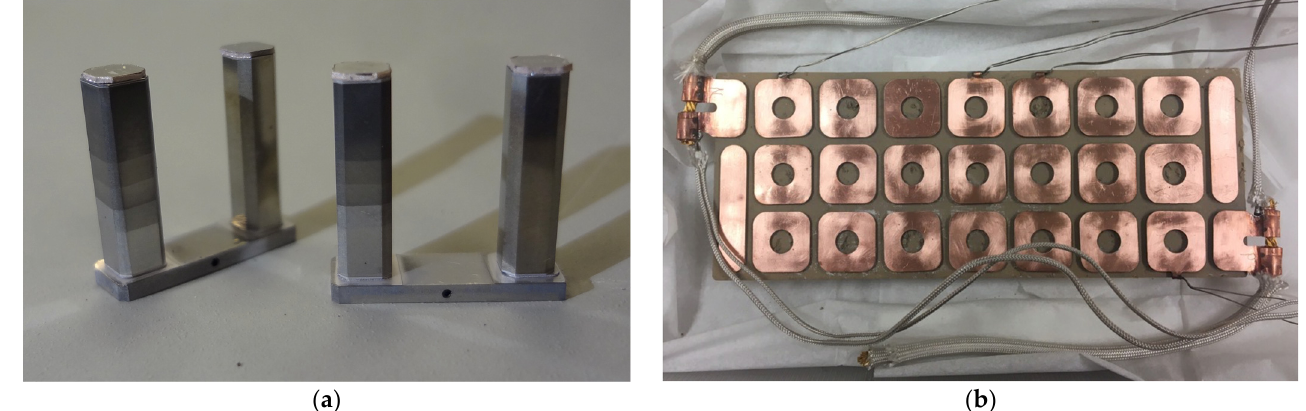
Figure 10. Photographs of ( a ) the eMMRTG SKD couple design currently on life testing and ( b ) the 1st SKD 48-couple module (bottom view showing the cold-side interconnects).